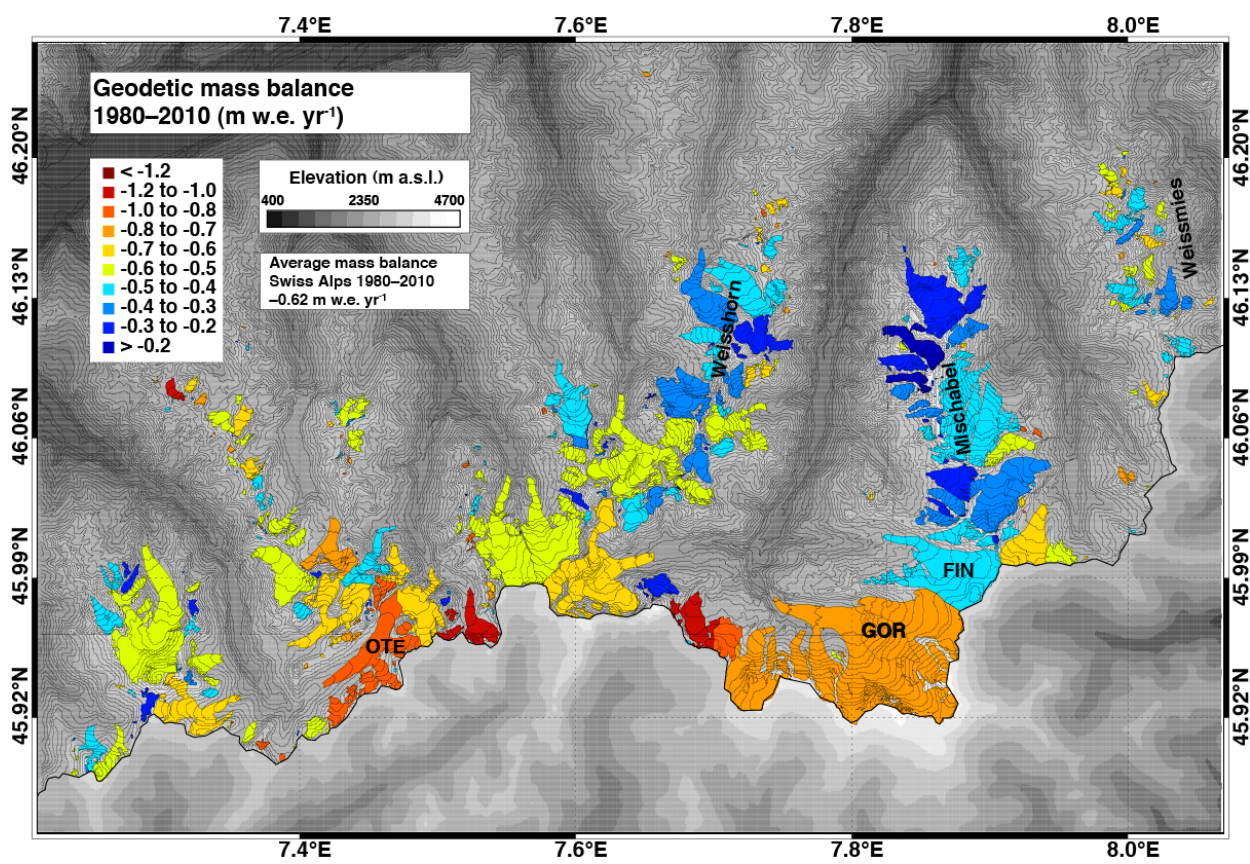
Figure 10. Spatial distribution of the temporally homogenized geodetic mass balance 1980–2010 for the central/eastern Valais Alps. The SGI2010 outlines are taken to illustrate glacier surface